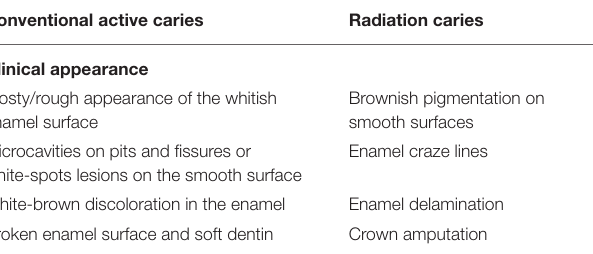
TABLE 1 | Difference between clinical conditions of conventional and radiation